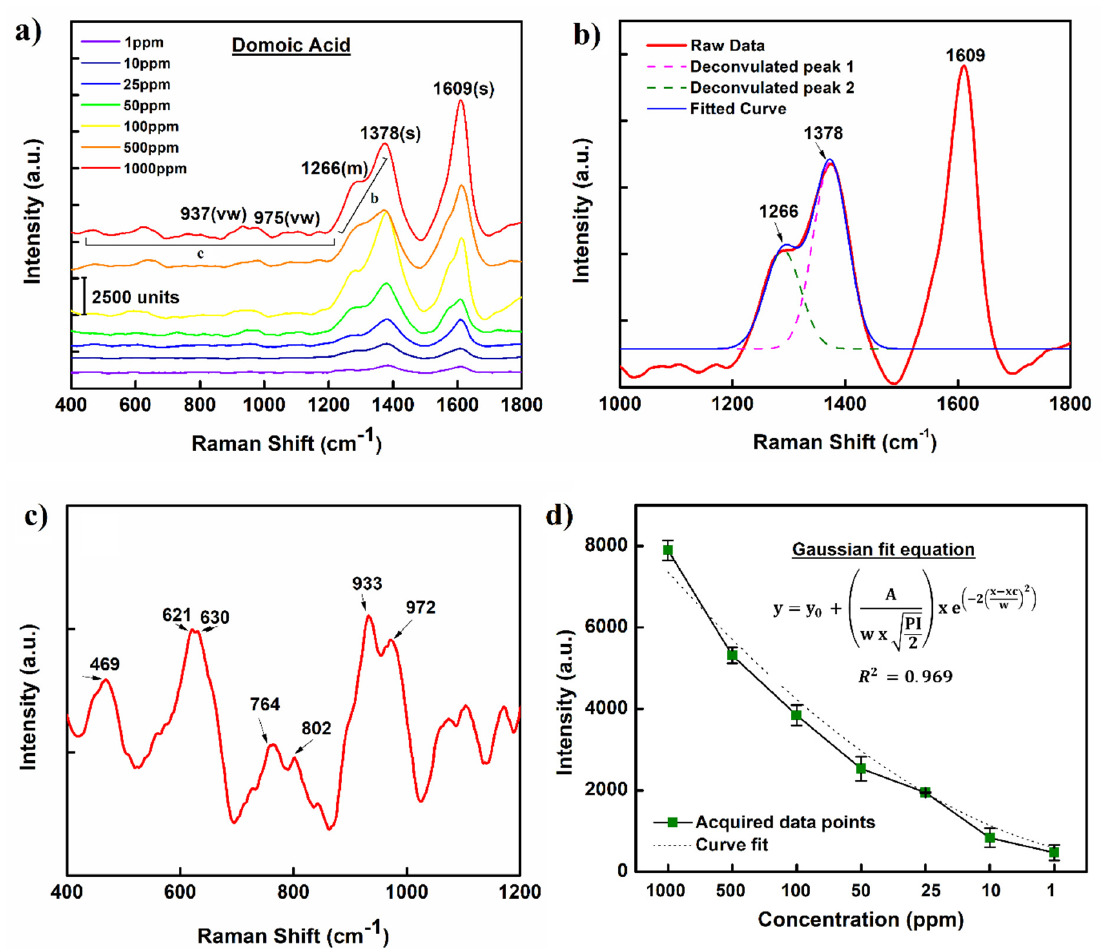
Figure 2. ( a ) Raman spectrum of DA at different concentrations (1000 − 1 ppm) acquired on AgNPs − DE SERS substrates. ( b − c ) Enlarged view of the acquired DA Raman spectrum over selective wavenumbers for detailed peak analysis. ( d ) Calibration curve representing relationship between DA concentration and Raman signal intensity. Notations s, m and vw represent strong, medium and very weak signal intensity respectively.